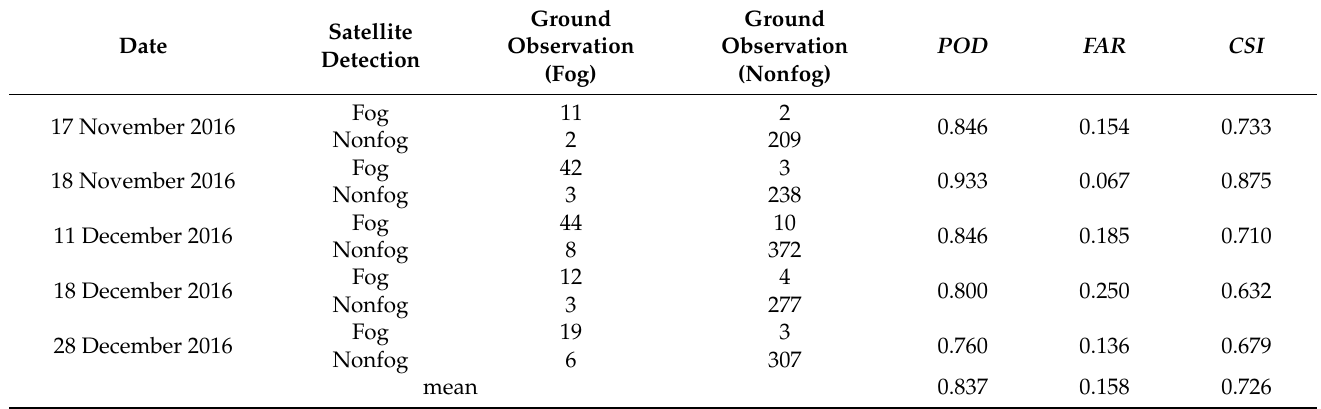
Table 3. Fog detection accuracy at 17:00 (BT).